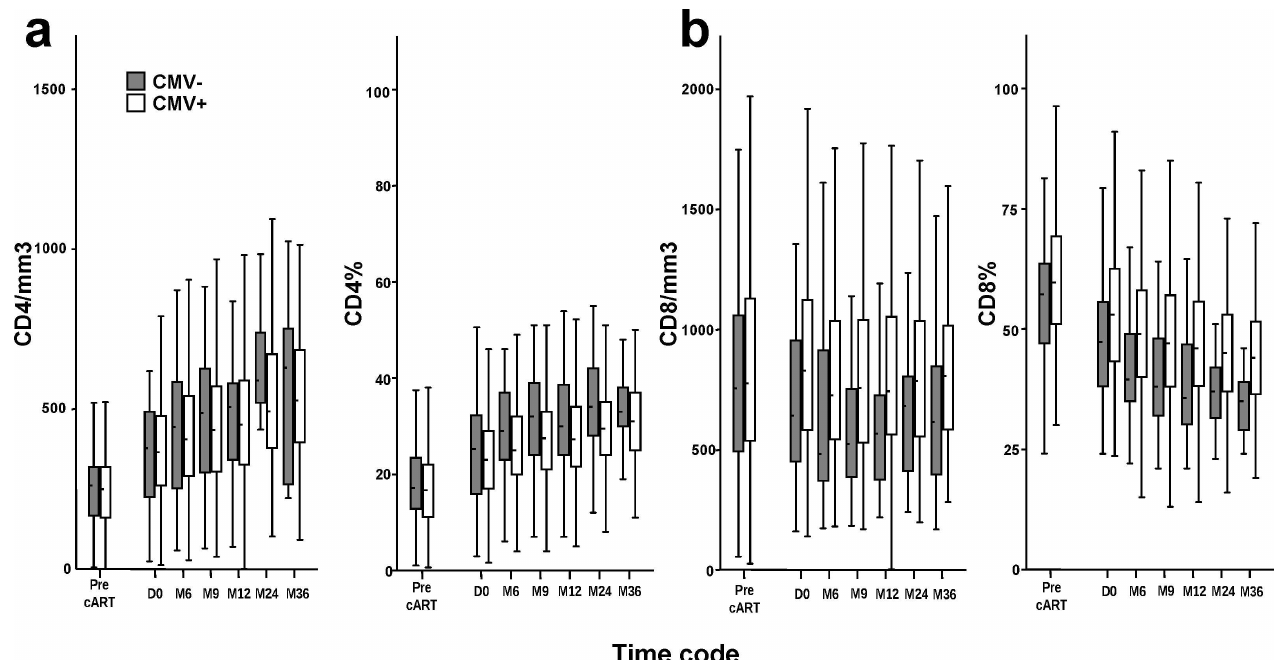
Fig 1. Longitudinal evolution of CD4+ and CD8+ T cell counts in CMV+ and CMV- HIV-infected patients on first-line cART. Box plots illustrate the medianand interquartileranges of CD4+ (a) and CD8+ (b) T cell counts and percentages in CMV+ (white) and CMV- (grey) HIV- infected patients on first-line